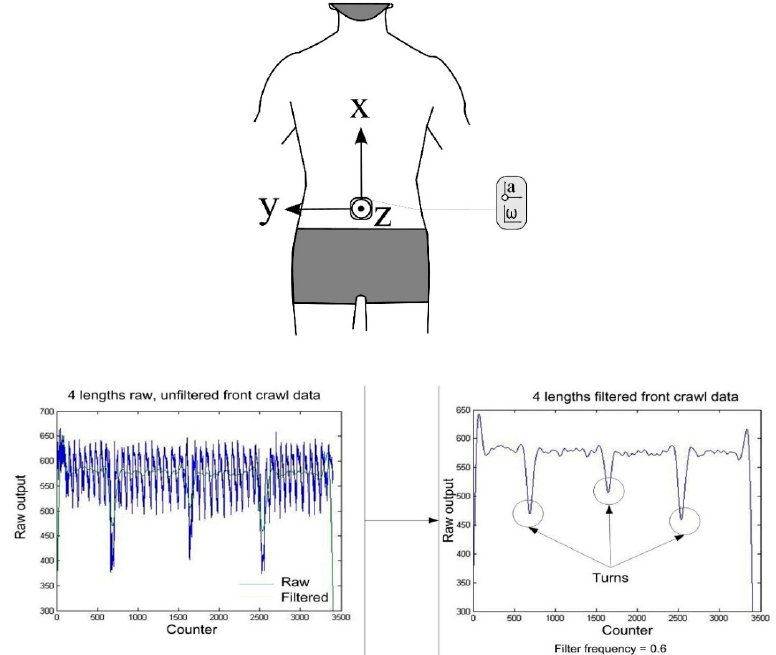
Figure 15. Turns performed during frontcrawl can be automatically detected by thresholding of the filtered acceleration signal from the axis perpendicular to the plane of movement as this undergoes a rapid change in acceleration as the swimmer rotates during the tumble. Reproduced with permissions from Le Sage, Bindel, Conway, Justham, Slawson and West [40].